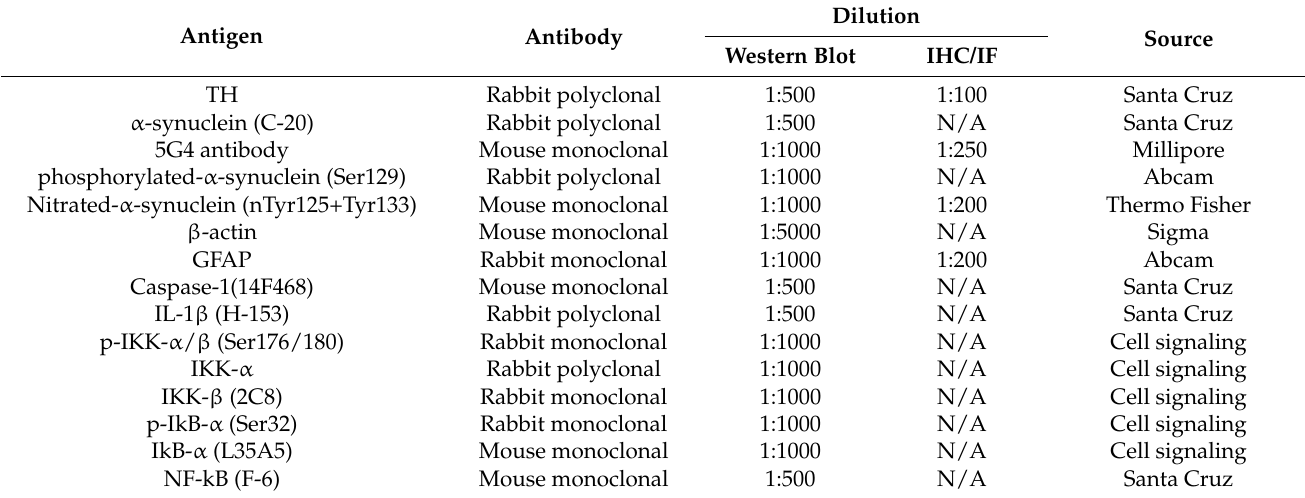
Table 1. The primary